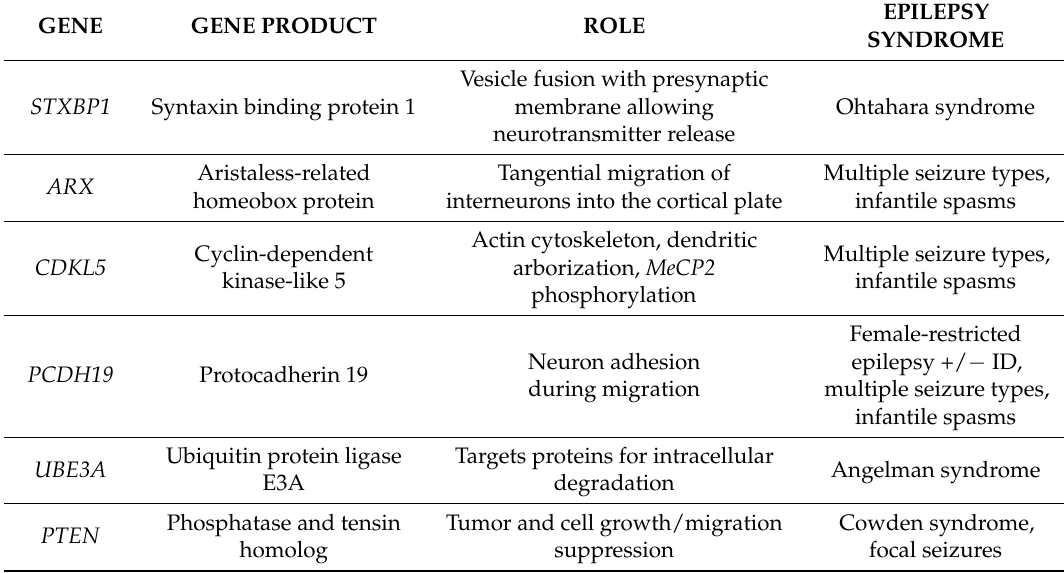
Table 1. Examples of genes in neurodevelopmental disorders with epilepsy that do not have simple or direct E/I imbalance as a mechanism of